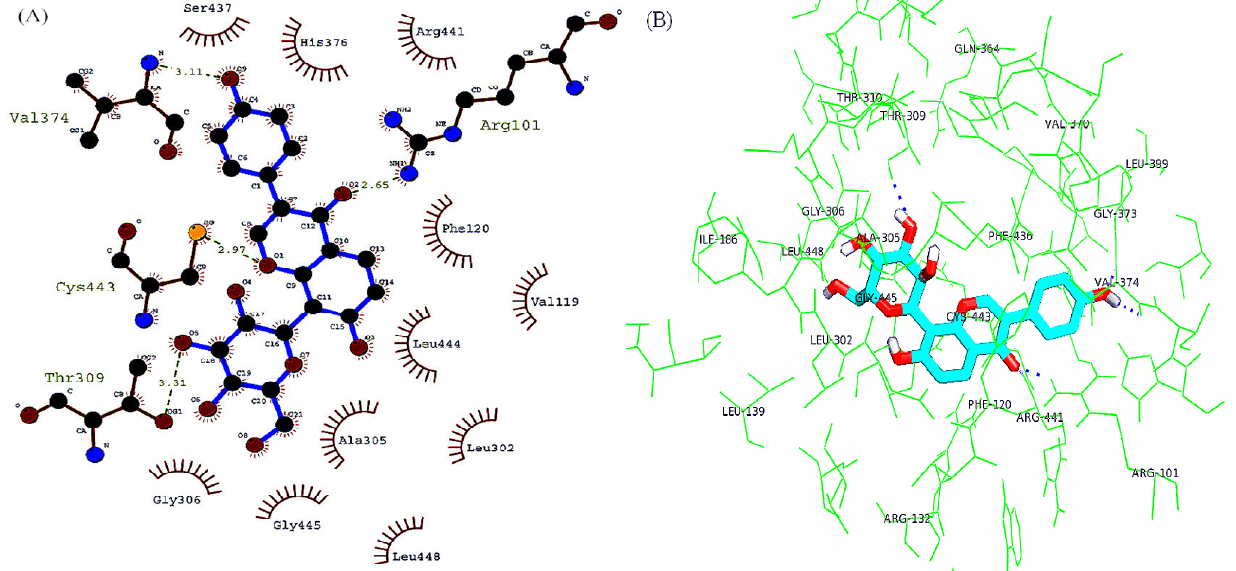
Figure 6. Molecular docking of interactions between puerarin and CYP2D6. ( A ) Ligplus; ( B )